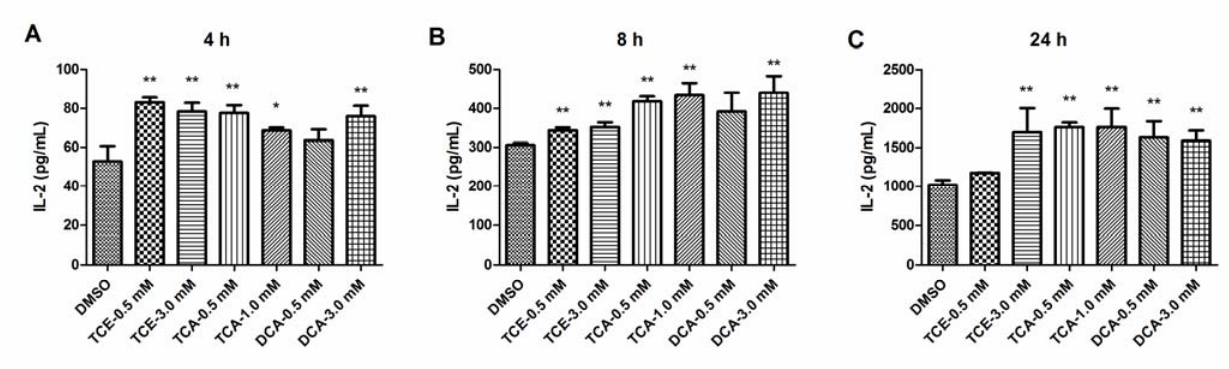
Figure 2. Effect of TCE, TCA and DCA on the production of IL-2 in PMA-/Ion-stimulated Jurkat cells. Cells were pretreated with TCE (0.5 and 3.0 mM), TCA (0.5 and 1.0 mM) and DCA(0.5 and 3.0 mM) for 16 h and then stimulated with PMA(50 ng/mL) and Ion (1 mM) for 4 h, 8 h and 24 h. The amounts of IL-2 in the cell supernatants after PMA/Ion stimulation for 4 h ( A ), 8 h ( B ) and 24 h ( C ) were measured by ELISA. The bars represent the mean ± SD of three independent experiments. * p ＜ 0.05, ** p ＜ 0.01 compared to